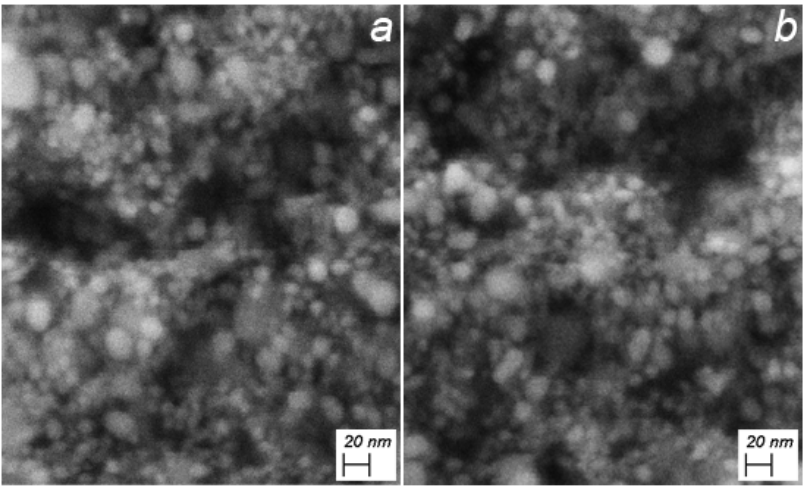
Figure 2. Morphology of ( a ) AgNPs and ( b ) AgNPs@11MUA. Operative condition: 7.00 kV, WD = 3.7 mm and Mag = 400.00 kX. EDX spectra of AgNPs and AgNPs@11MUA are reported in Figure 3a,b, respectively. After dialysis, the EDX spectrum of AgNPs@11MUA revealed the presence of sulfur in the AgNPs@11MUA sample, indicating a good functionalization process.